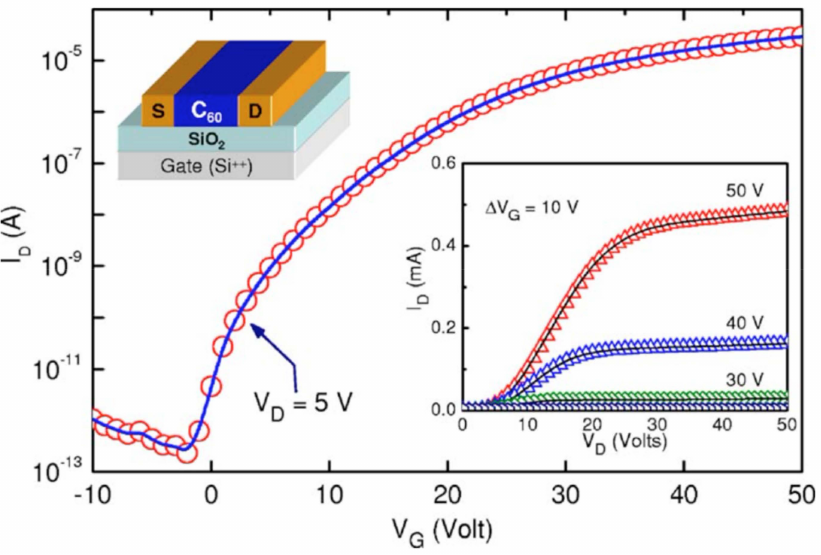
Figure 9. The typical curve of the source-drain current, versus source-gate voltage at a given source- drain voltage. Reprinted from [147], with the permission of AIP